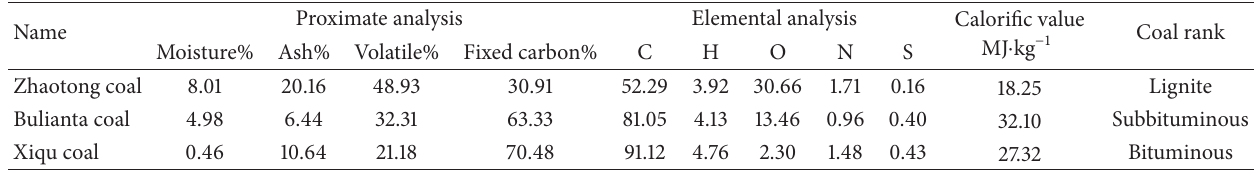
Table 1: Technical parameters of experimental coal samples.